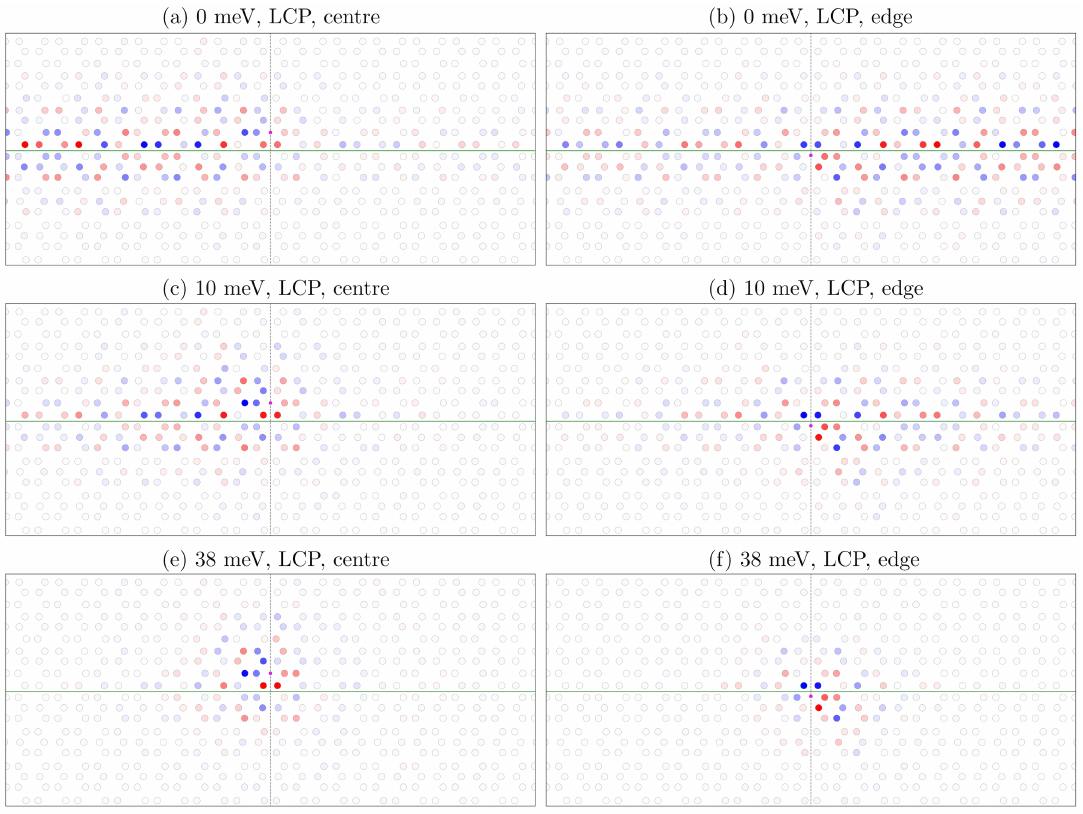
Figure A5. Propagation along lossy interfaces: Increasing material losses does not affect the directionality behaviour along the